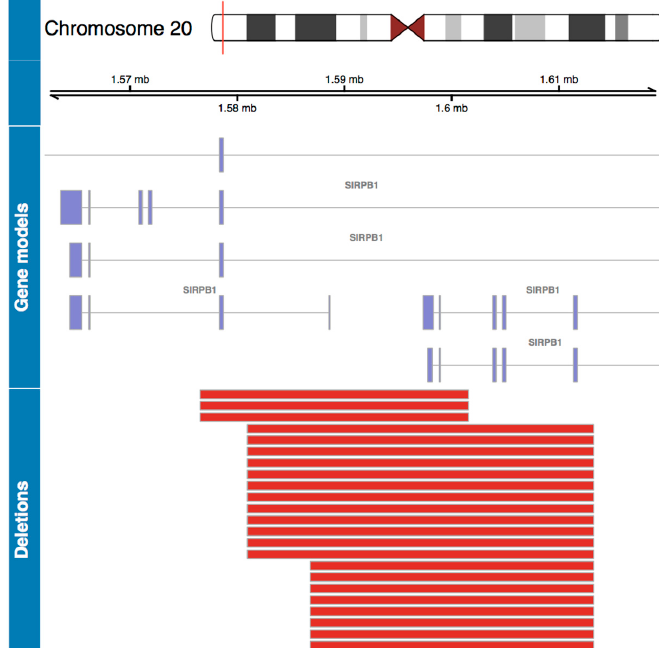
Figure 3. Genomic map for statistically significant deletions in mild patients. Top panel shows the chromosome containing the associated regions with the coordinates, and the region of interest marked in red. The middle panel shows the gene models of the alternative transcripts of the SIRPB1 gene located in the region of interest. The bottom panel shows the size of each CNV deletion along the same genomic coordinate, each red line corresponds to a deletion in a